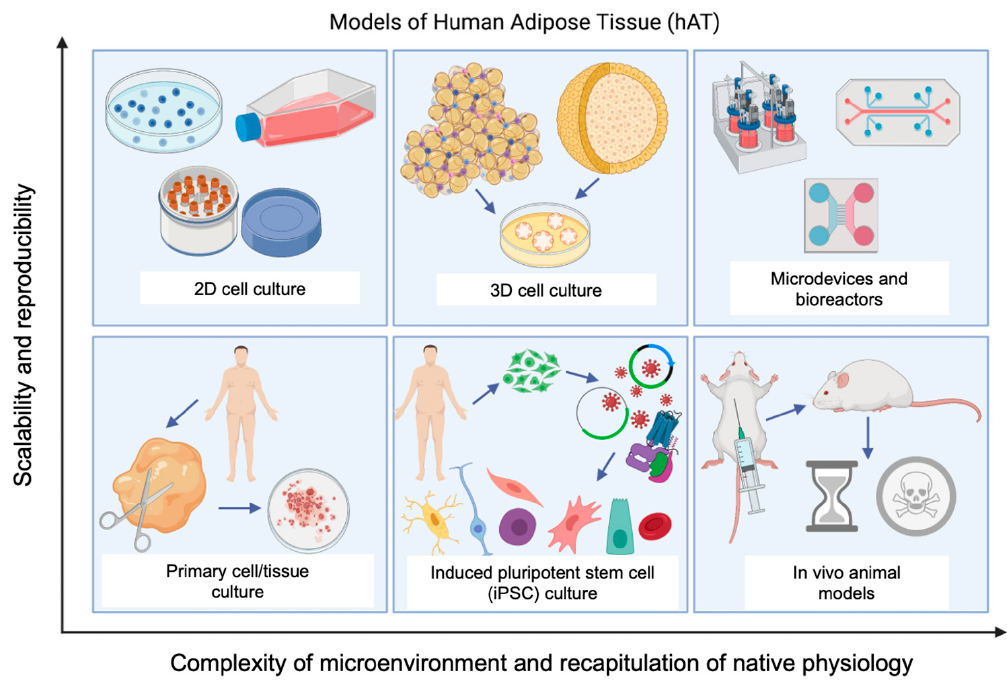
Figure 1. Diagram demonstrating the scalability, reproducibility, complexity, and physiological relevance of available human adipose tissue models. Image created with BioRender.com.